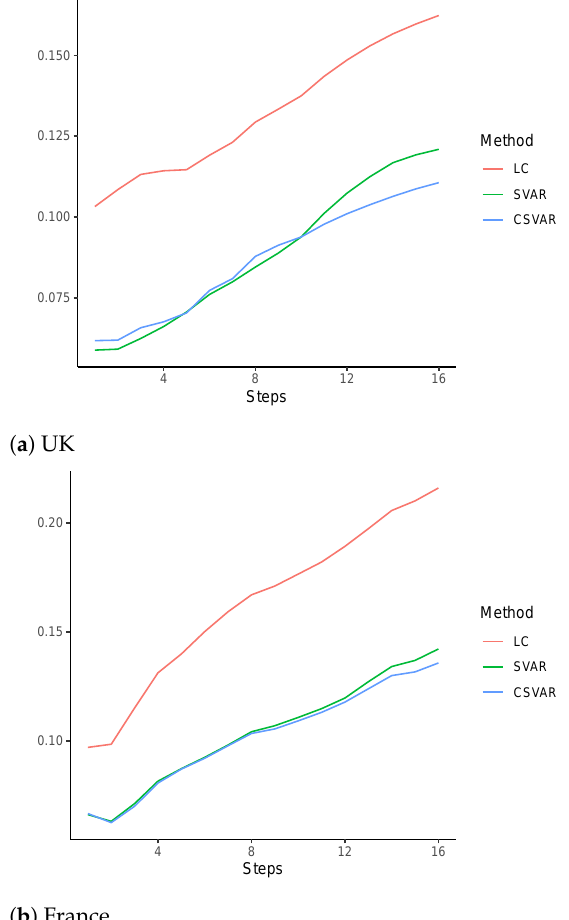
Figure 5. RMSE over forecasting steps.